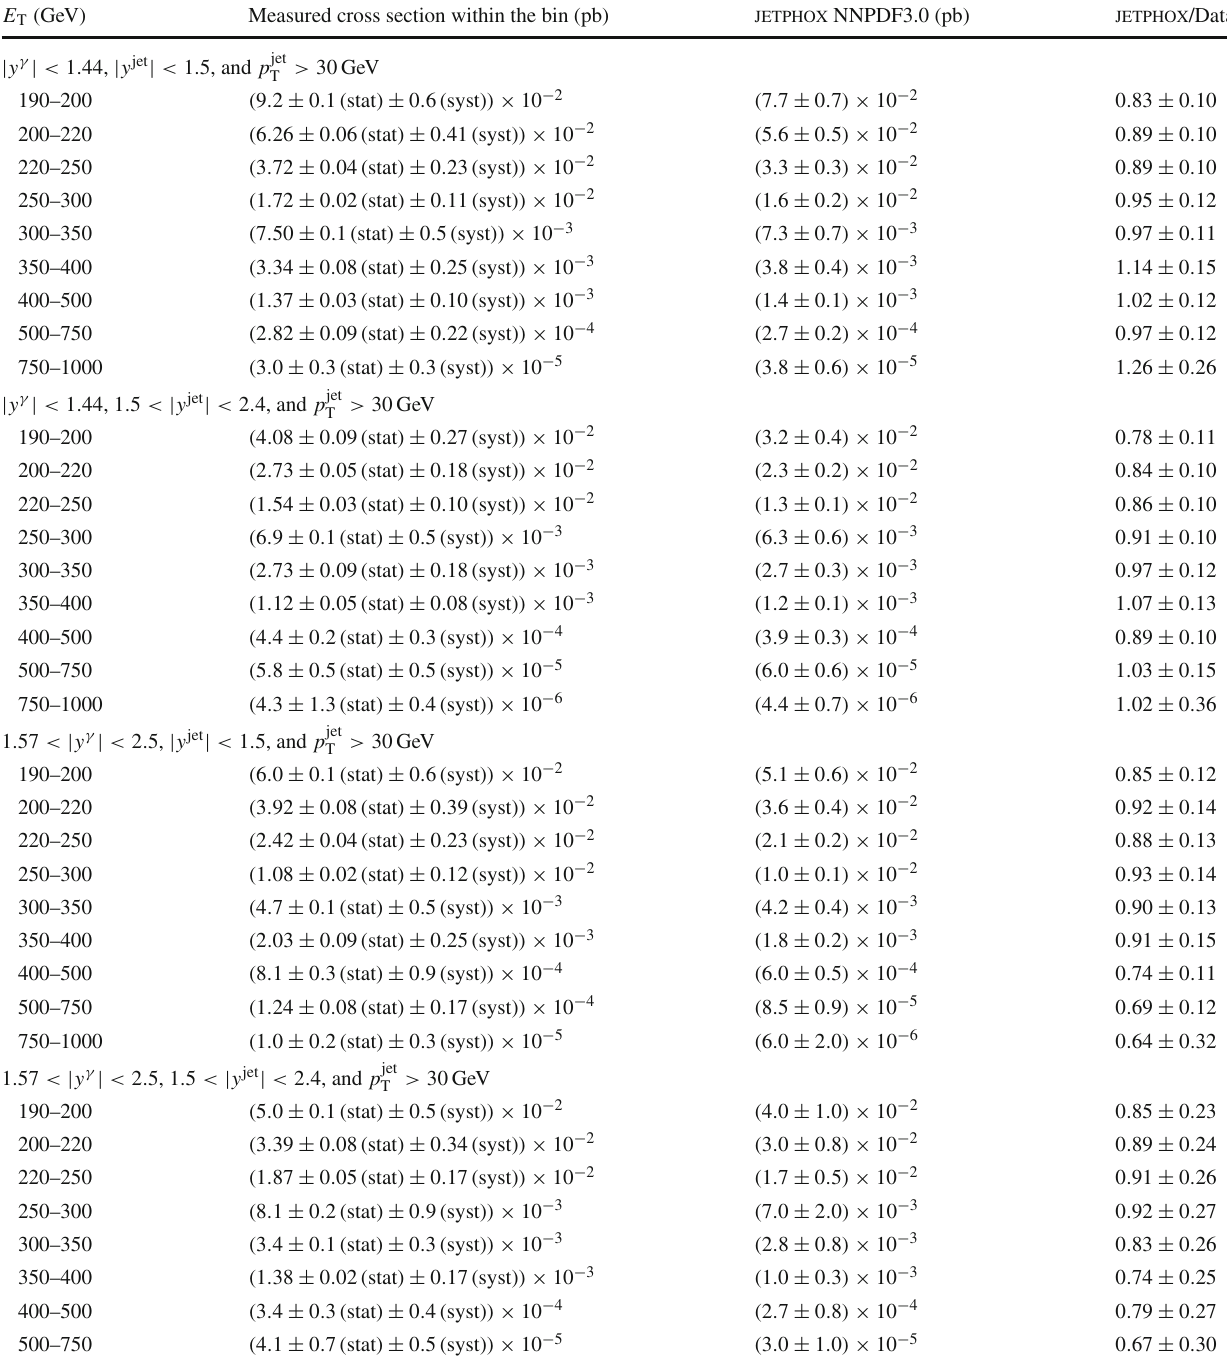
Table 3 Measured and predicted differential cross section for pho- with the NNPDF3.0 PDF set. The ratio of the jetphox predictions to ton+jet production, along with statistical and systematical uncertainties thedataarelistedinthelastcolumn,withthetotaluncertaintyestimated in the various E T and y bins. Predictions are based on jetphox at NLO assuming uncorrelated experimental and theoretical uncertainties Measured cross section within the bin (pb) jetphox NNPDF3.0 (pb) jetphox